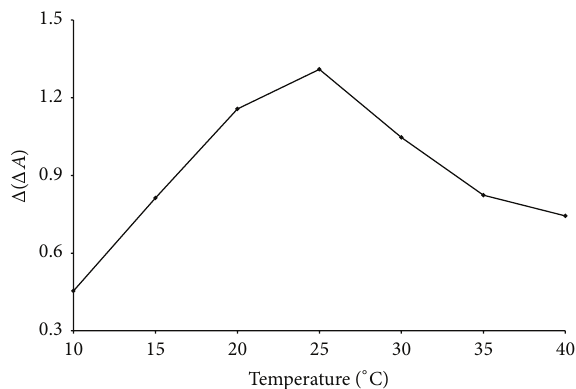
Figure 7: Effect of temperature on the sensitivity. Conditions: H 2 SO 4 , 2.4 M; SCG; 12ng mL −1 ; TBAB, 1.0 × 10 −3 M; amaranth, 1.4 × 10 −4 M, IO 4− 4.0 × 10 −4 M.